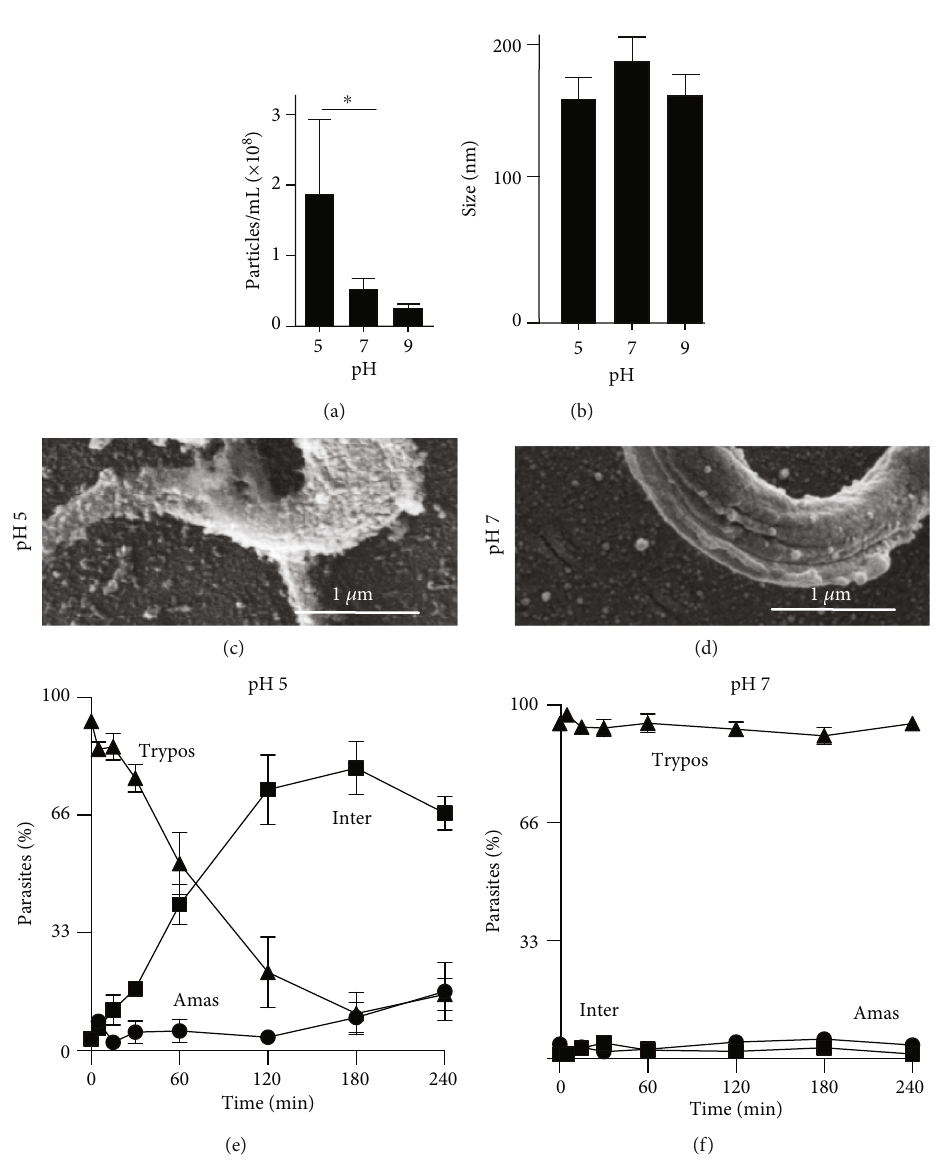
Figure 3: pH e ff ect on EV release. Trypomastigote ( 1 × 10 7 /mL) forms incubated (2 h, 37 ° C) in culture medium containing 5% glucose previously adjusted to the indicated pH values. EV concentrations (a) and sizes (b) were analyzed by NTA ( ∗ p < 0 : 05 ). After incubation at pH 5 (c) or pH 7 (d), parasites were analyzed by SEM. In parallel, parasites were incubated at pH 5 (e) or pH 7 (f), stained with Giemsa, and 300 parasites were evaluated according to their form: trypomastigotes (Trypos), intermediate (Inter), or amastigote (Amas). Their percentages were quanti fi ed in